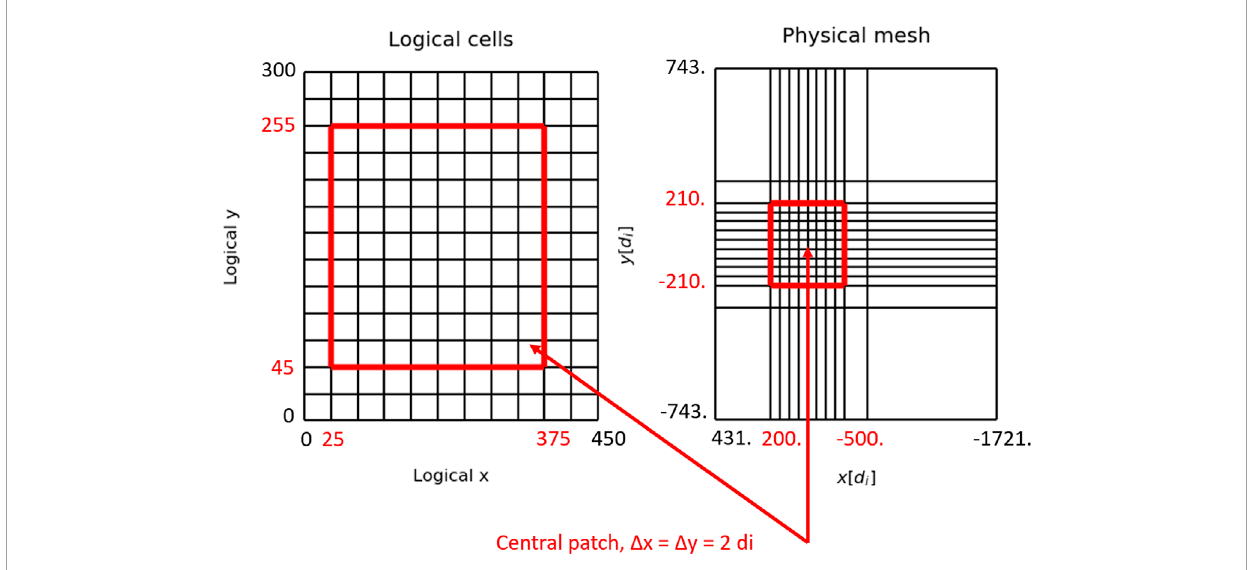
FIGURE 1 2D (x–y) projections of logical and stretched (physical) meshes. The red color shows the boundaries of a central patch with the maximum uniform resolution of Δ x = Δ y = 2 d i .